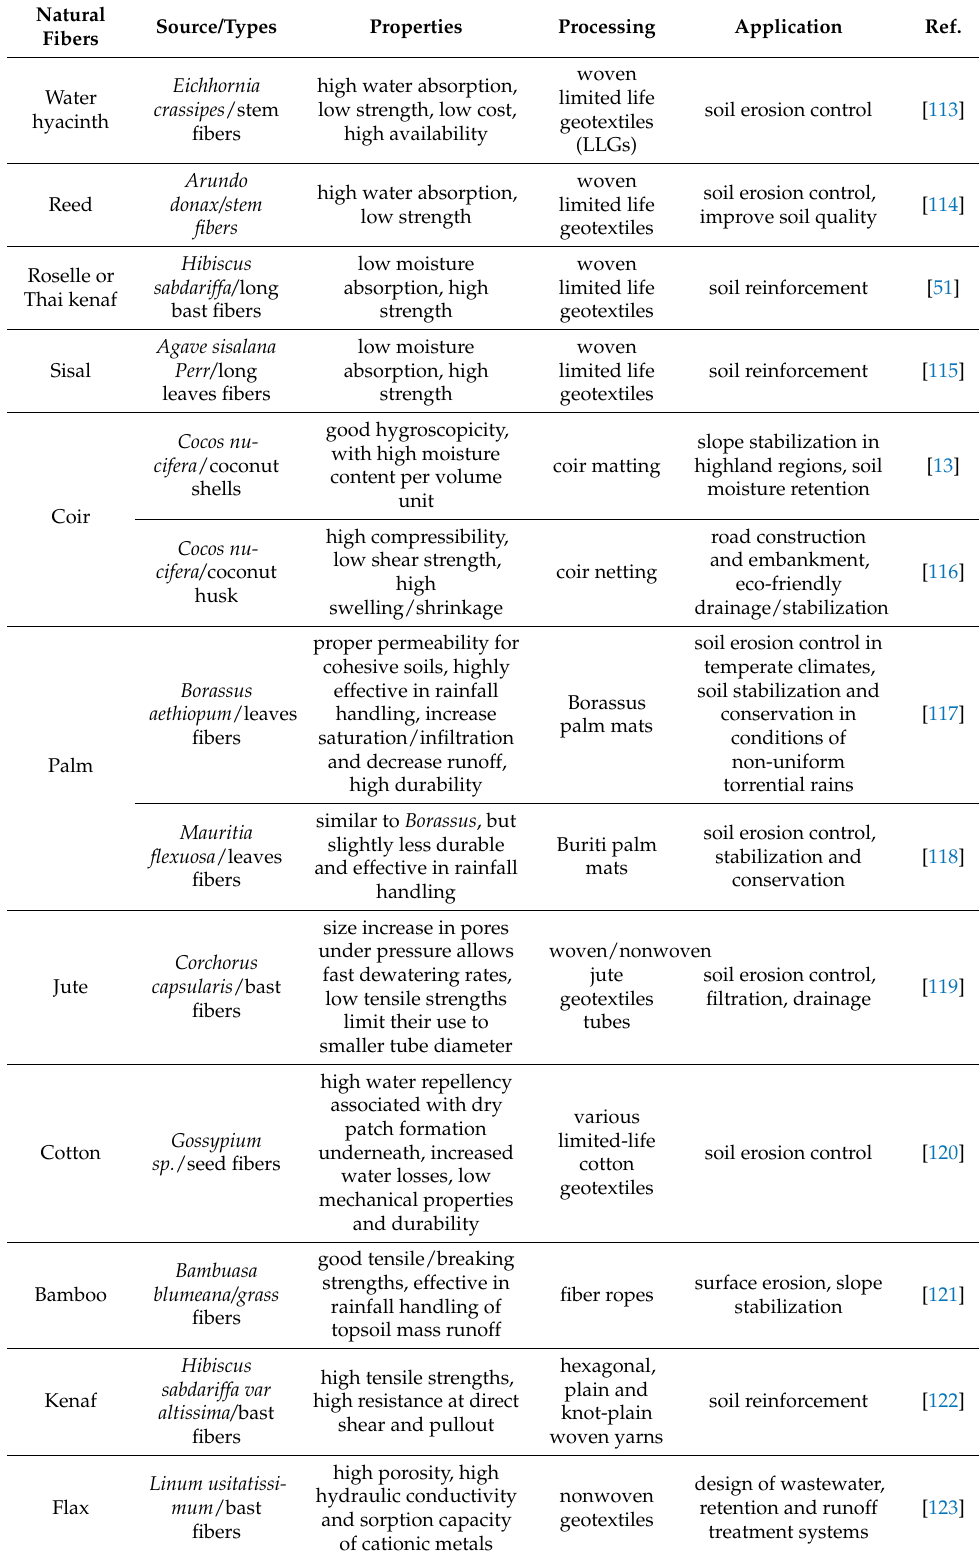
Table 2. Examples of employment of natural fibers in geotechnical